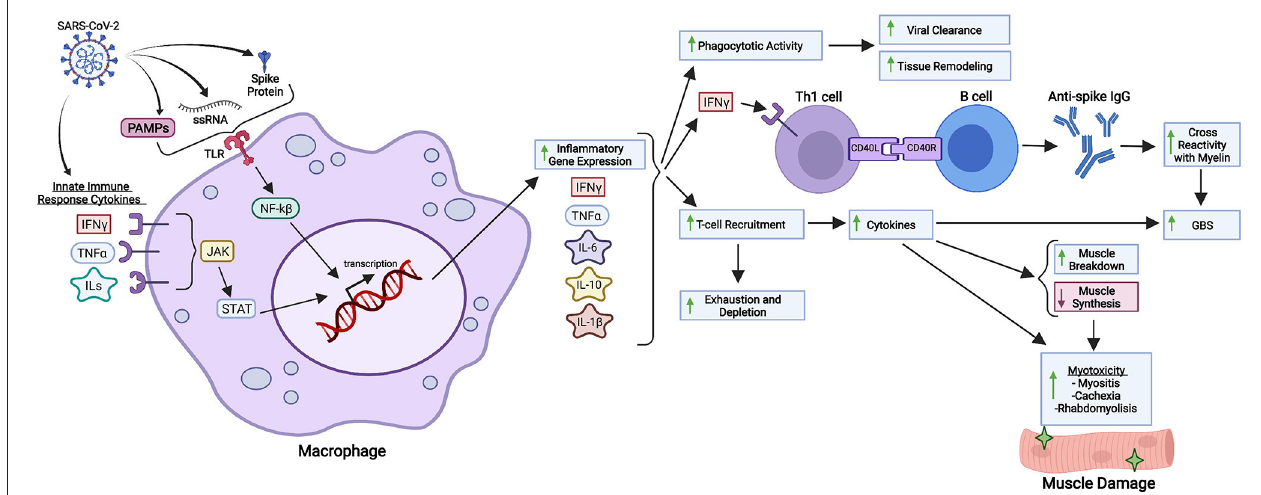
FIGURE 1 | Inflammatory and immunological repercussions of SARS-CoV-2 infection. SARS-CoV-2 components such as the S protein, PAMPs and viral single-stranded RNA (ssRNA) are recognized by macrophages and other immunological cells through Toll-Like Receptors (TLR), triggering intracellular cascades responsible for initiating inflammatory gene expression and cytokine production. Cytokines from the innate immune response against COVID-19 also intensify inflammatory gene expression through different pathways, such as JAK-STAT signaling. Increased synthesis of IL-6, IL-10, IL-1ß, IFN- γ and other cytokines in response to viral infection enhance phagocytotic activity, B cell class differentiation into IgG synthesizing plasmocytes and tissue-specific T-cell recruitment. Phagocytotic activity is related to viral clearance and tissue remodeling as a response to chronic inflammation. Anti-spike IgG might cross-react with neuronal myelin, predisposing SARS-CoV-2 infected patients to GBS (Guillain-Barré Syndrome), a disease whose development is also associated with cytokines produced in the setting of SARS-CoV-2 infection. Lastly, T-cell recruitment is associated with increased production of cytokines, which not only enhance myotoxicity through decreased muscle protein synthesis and increased protein degradation, but also deplete circulating T cells, which can aggravate systemic immunological response to infection. Created with